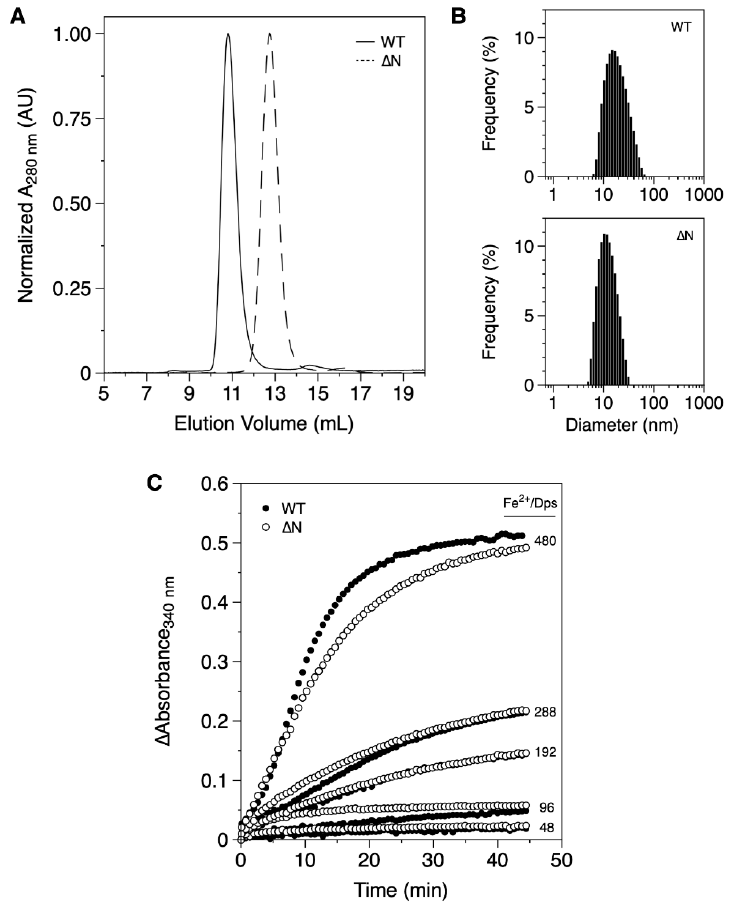
Figure 1. Biochemical characterization of purified fractions of DgrDps WT and ∆ N variant. ( A ) SEC elution profiles of DgrDps WT (full line) and ∆ N (dashed line); ( B ) DLS particle size distribution of DgrDps WT and ∆ N variant samples; ( C ) progress curves of the Fe 2+ ions oxidation reaction in the presence of O 2 , for different amounts of the iron substrate (Fe 2+ /protein molar ratios of 48, 96, 192, 288 and 480). In all experiments the protein was buffered in 200 mM MOPS pH 7.0 and 200 mM